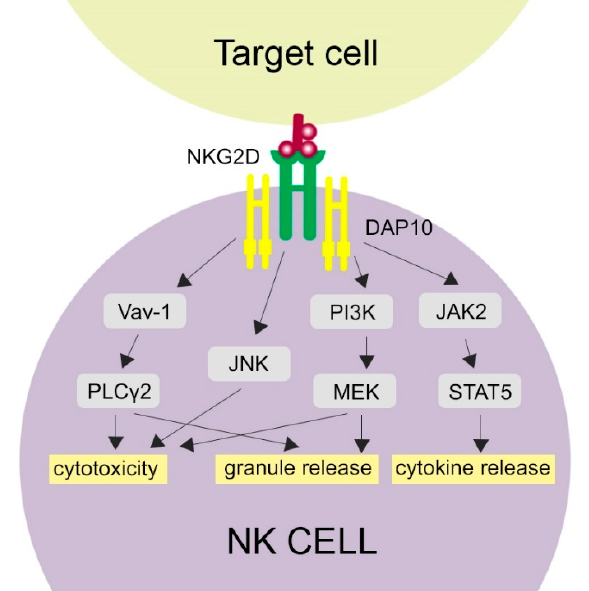
Figure 1. Activation of NKG2D-related pathways. NKG2D binding with its ligand activates several molecular pathways in NK cells, which is provided by the DAP10 signaling molecule. Cytotoxicity of NK cells may be activated through phospholipase C Gamma 2 (PLC γ 2), c-Jun-NH (2)-terminal kinase (JNK) and phosphatidylinositol 3-hydroxy kinase PI3K. Granule release is activated by the PLC γ 2 and PI3K pathways. The JAK-STAT5 (Janus kinase 2-Signal Transducer and Activator of Transcription 5) pathway results in cytokine release.